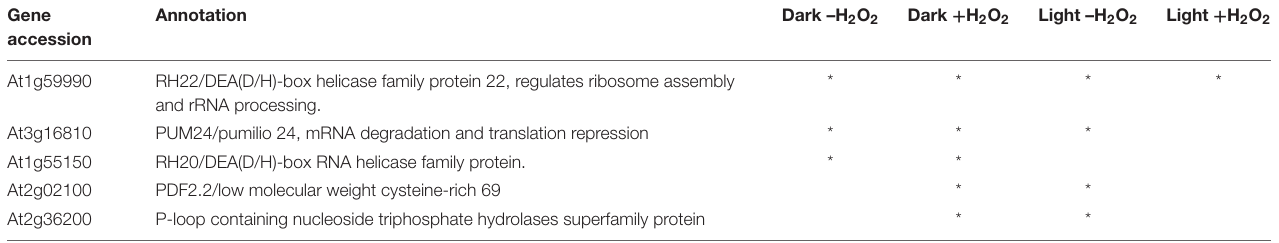
TABLE 1 | Tandem affinity purification tagging identification of proteins interacting with LEA5. Gene accession